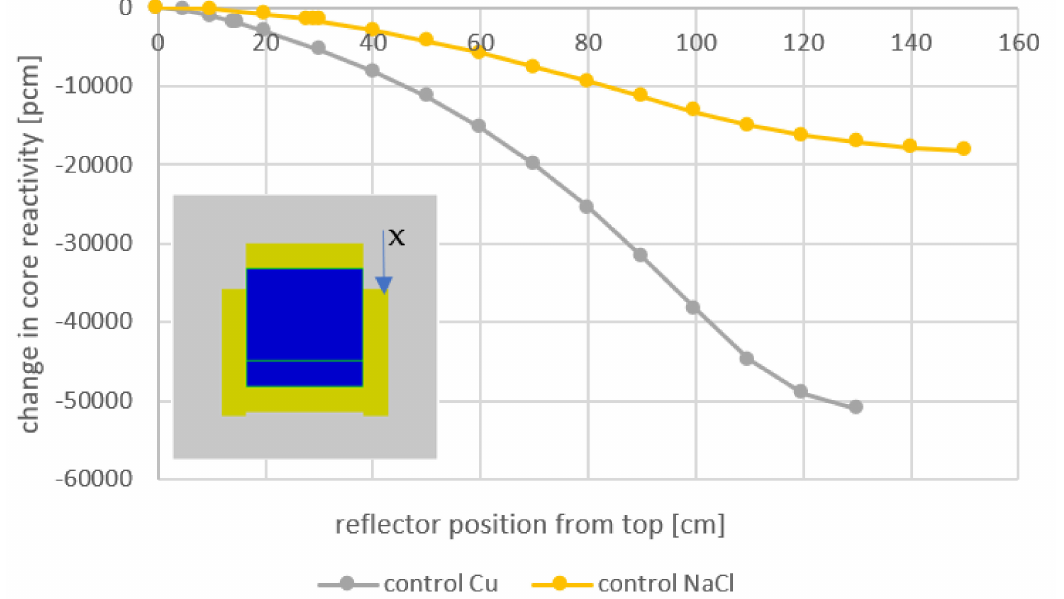
Figure 17. Comparison of the control curve caused by moving the reflector made of NaCl and copper, with the systematics of the study described in the insert.